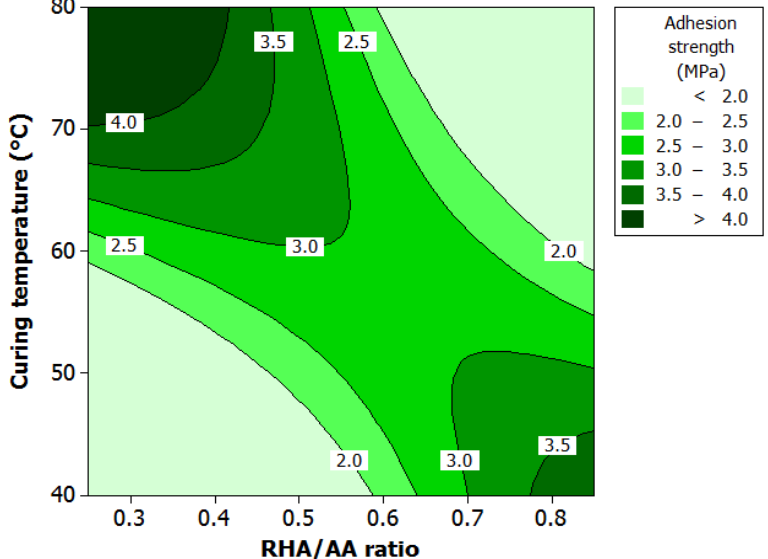
Figure 5. Contour plot for the effect of RHA/AA ratio and curing temperature on the adhesion strength.